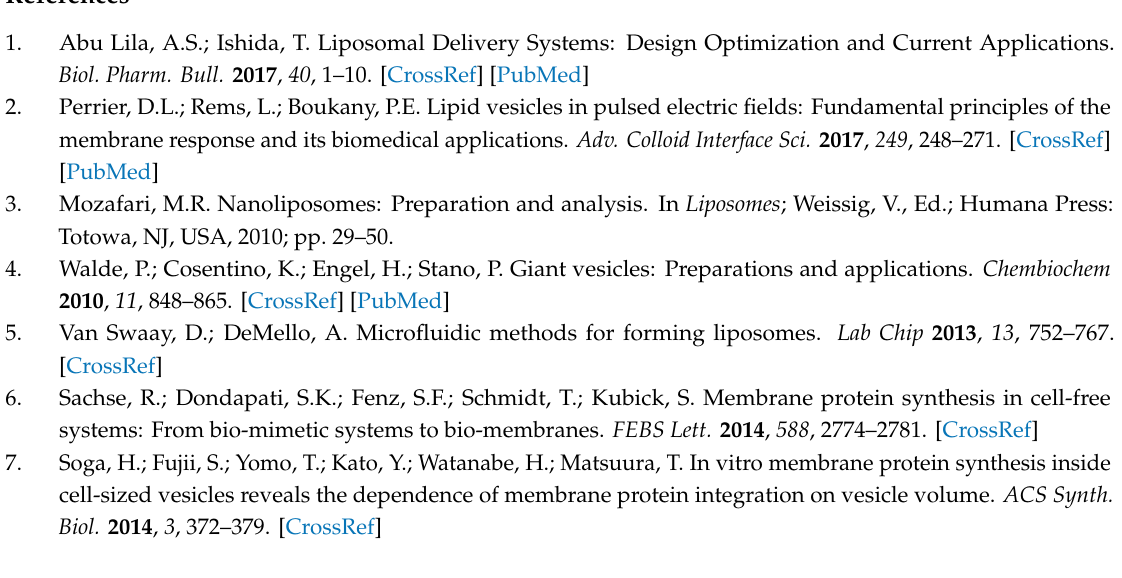
Table S1: Complete calculated liposome concentrations values ± error for both POPC_LIPO and MIX_LIPO (these data are graphically reported in Figure 3). Figure S1: Static light scattered intensity measured for I and II POPC_LIPO_50 extrusions, reported as a representative example. Figure S2: Emission elastic peaks and corresponding peak areas measured for I and II POPC_LIPO_50 extrusions, reported as a representative example. Table S2: Experimental values, parameters and results for one POPC_LIPO_50 sample reported as a representative example. Table S3: Calculated liposome concentrations values ± error for the two independent POPC_LIPO_100_A Figure S3: Graphical representation of data reported in Table S3, as a representative